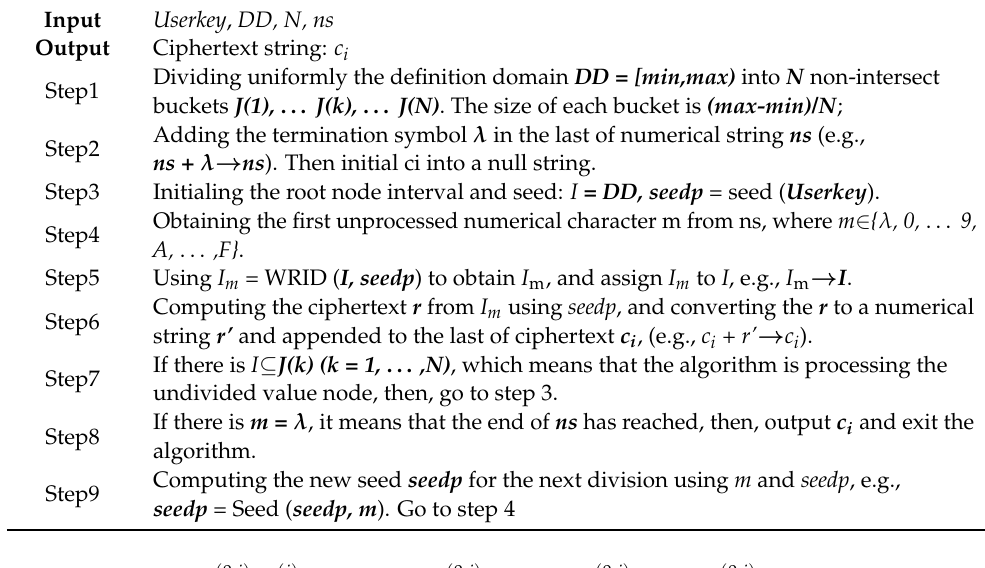
Algorithm 2: The encryption processes of numerical string using OPRIT and WRID